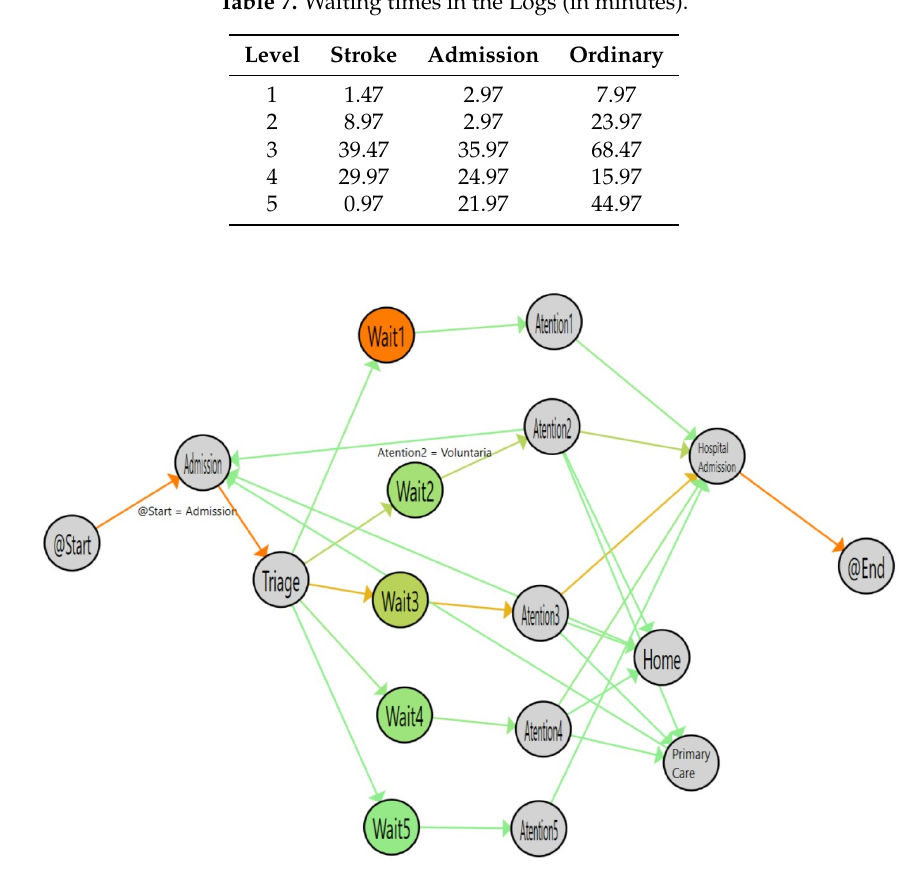
Figure 14. Adequacy of the Admission of patients according to the Manchester